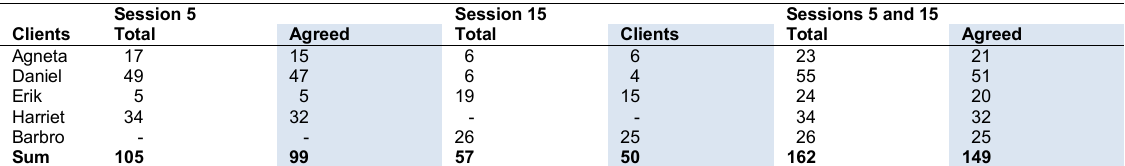
Table 1. Comparisons of